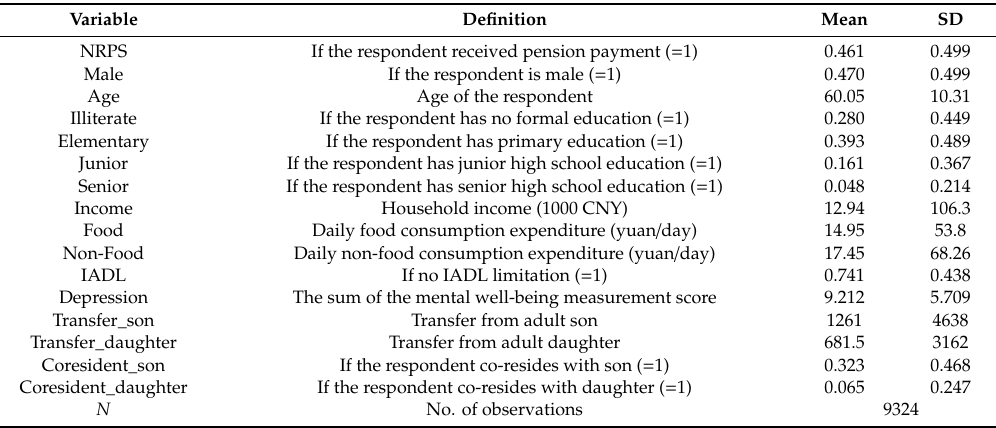
Table 1. Variable definitions and summary